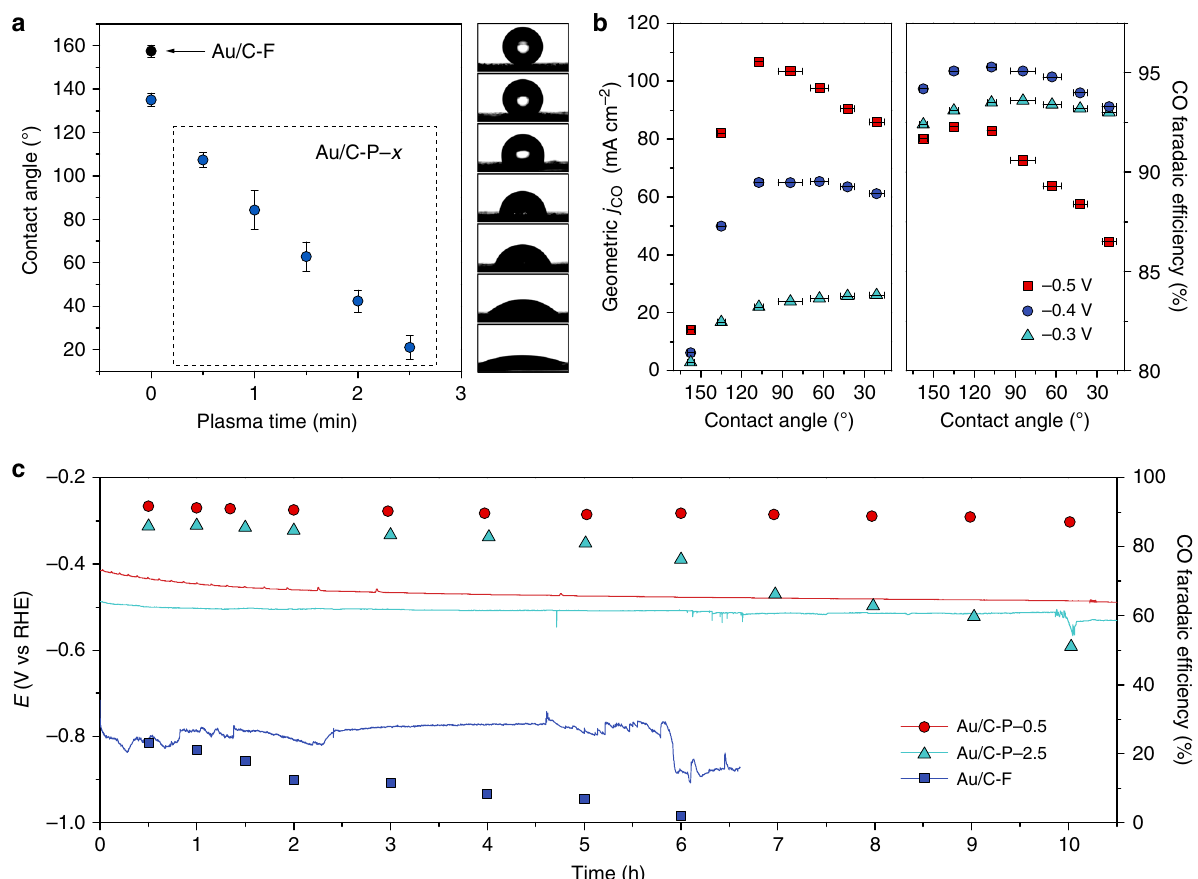
Fig. 2 Effect of interfacial wettability on electrochemical CO 2 RR performance. a Plot of average water droplet contact angles on different Au/C electrodes and photographs of water droplets on each electrode. b Geometric j CO and CO Faradaic ef fi ciency of Au/C electrodes with various water CAs at − 0.3, − 0.4 and − 0.5 V vs. RHE. Error bars represent the standard deviation of three independent experiments. c Cathode chronopotentiometry tests for Au/C-F, Au/C-P-0.5 and Au/C-P-2.5 in 1 M KOH at a constant current density of 100 mA cm − 2 (without i R correction). Source data are provided as a Source data fi